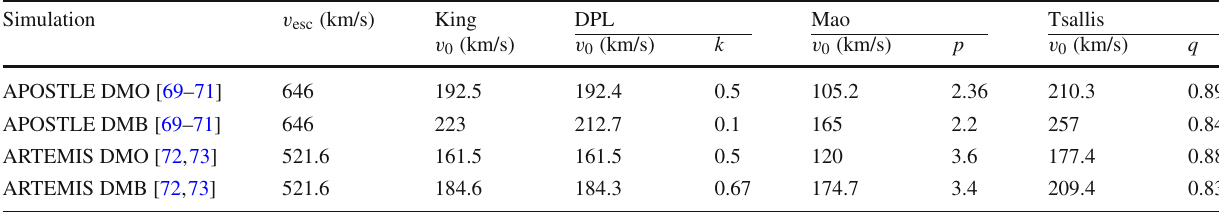
Table 2 Best fit values used to derive the exclusion limit for King, DPL, Mao, and Tsallis model